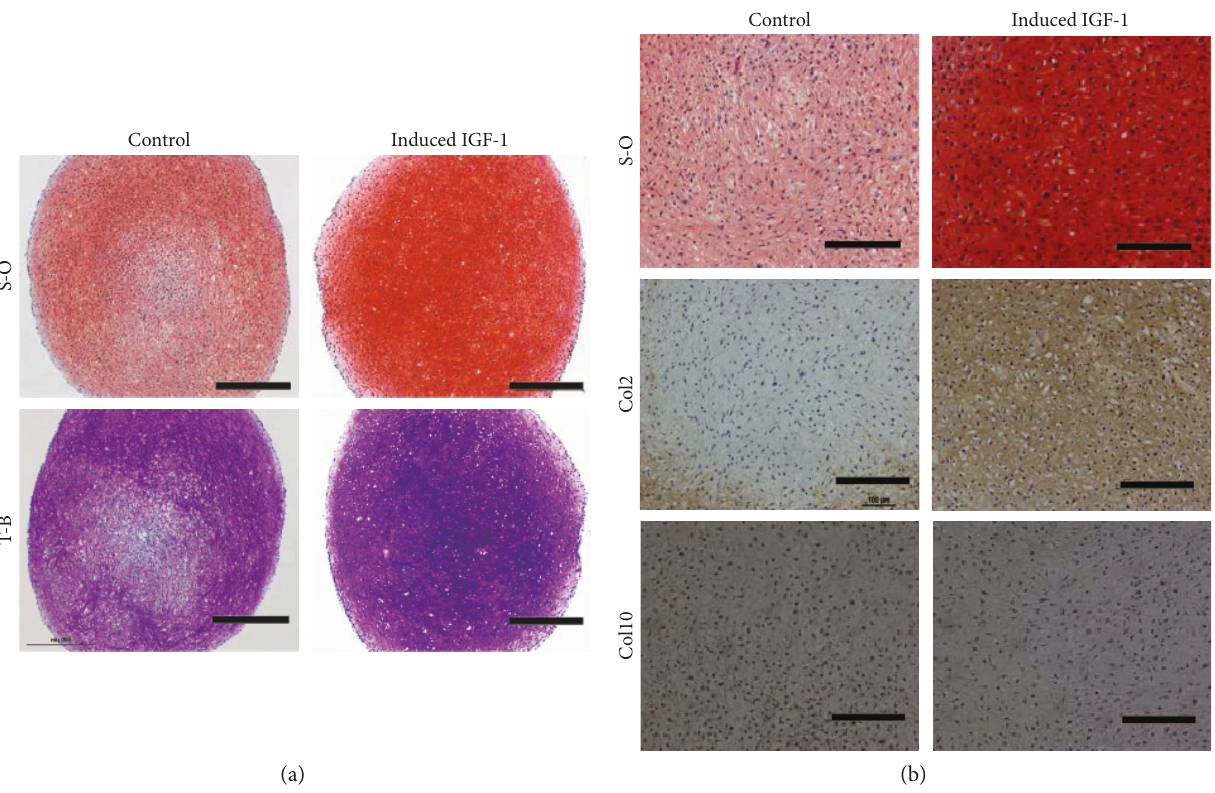
Figure 3: The results of histology and immunostaining assessments. (a) S-O; safranin-O (upper lane), T-B; toluidine blue (lower lane). Control (left) versus IGF-1 gene transferred cell-derived pellets (right). Scale bars = 500 μ m. (b) S-O; safranin-O (upper lane), Col2; type II collagen (middle), and Col10; type X collagen (lower) immunostaining. Control (left) versus IGF-1 gene transfer (right). Scale bars =200 μ